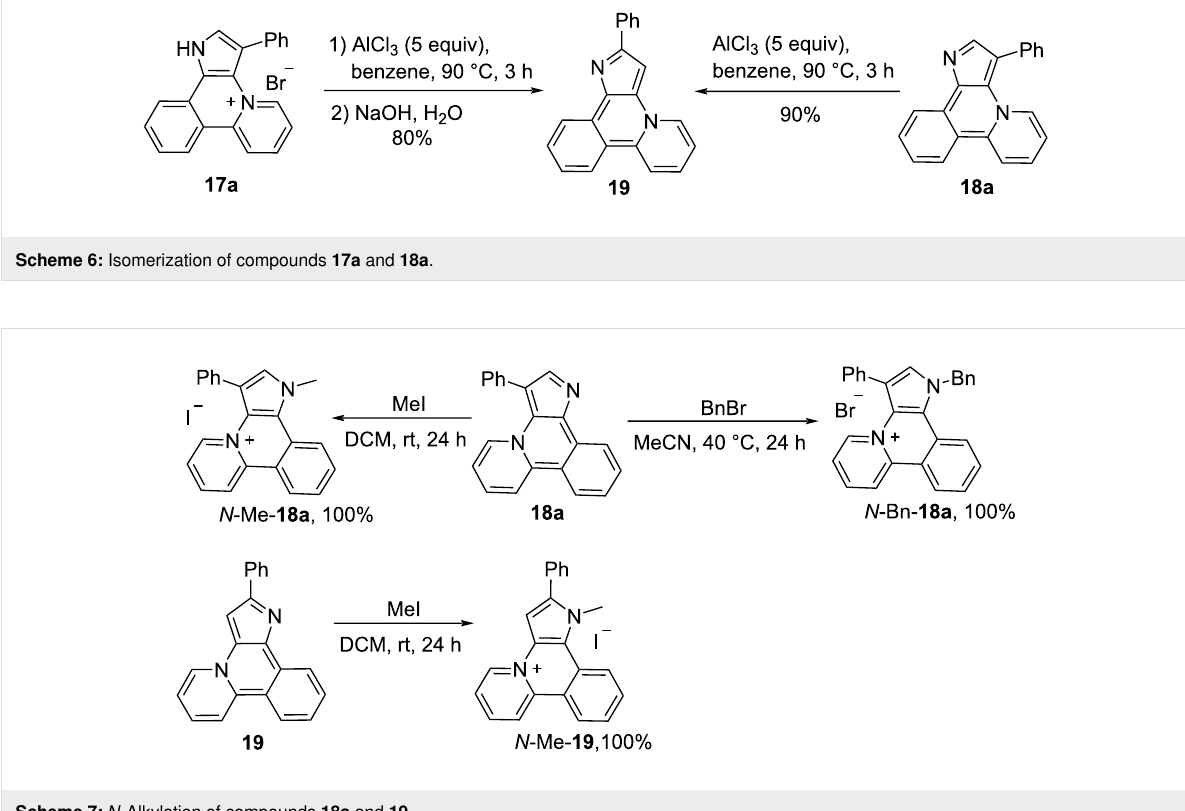
Scheme 7: N -Alkylation of compounds 18a and 19 .